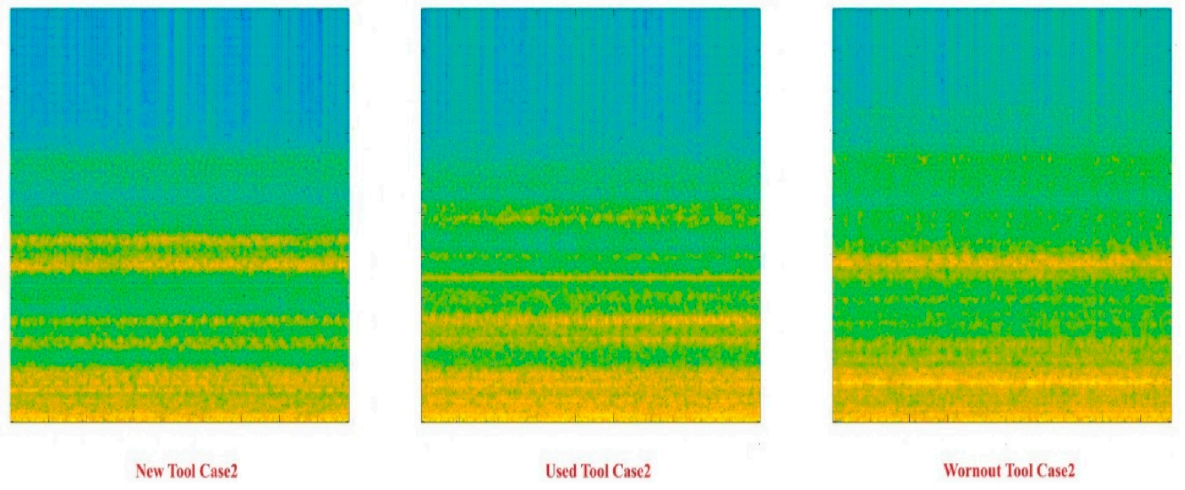
Figure 23. Spectrograms (training samples) of new, used, and worn-out tool conditions for Case 2.